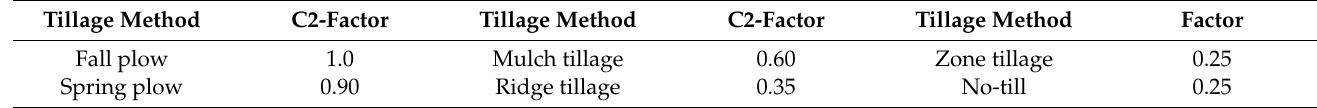
Table 8. Tillage method factor (C2-Factor) scores.